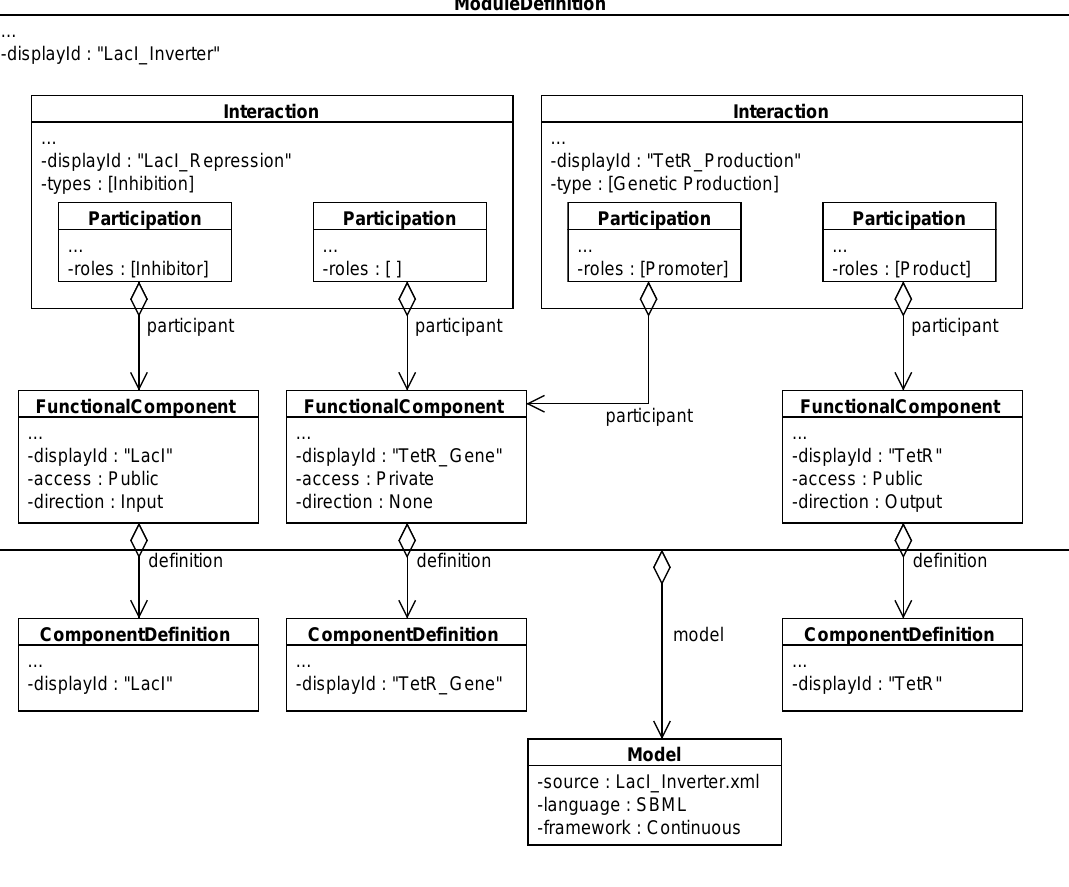
Figure 31: ModuleDefinition of the LacI inverter. This ModuleDefinition contains FunctionalComponent ob- jects that instantiate the ComponentDefinition objects for the LacI/TetR transcription factors and TetR gene. These FunctionalComponent objects participate in a repression Interaction and a genetic production Interaction , thereby indicating which biological structures carry out the function of the LacI inverter ModuleDefinition . In this case, the transcription and translation of TetR are represented as a single genetic production Interaction that abstracts away the presence of the intermediate TetR mRNA. In addition, this ModuleDefinition is also associated with a continuous Model written in the SBML source file